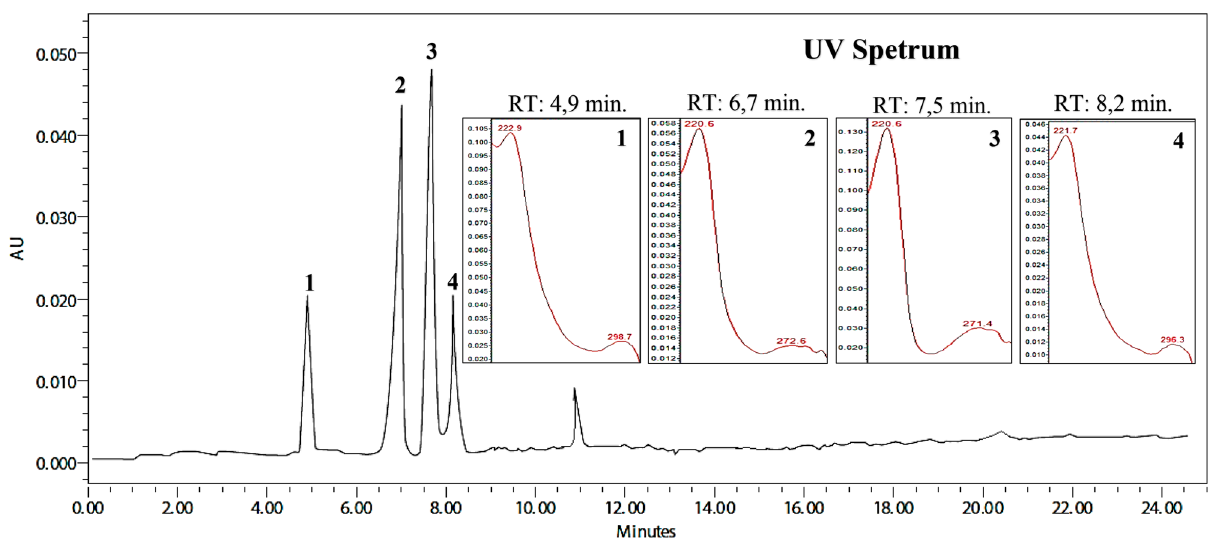
Figure 3. Chromatographic profile and UV spectra of the alkaloid fraction of Aspidosperma nitidum . λ = 250– 400